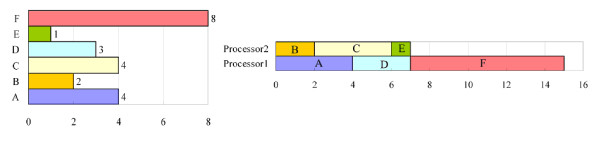
An example of the first potential problem of parallel signature discovery. The tasks can be completed in 22 time units by a single-processor computer. The overall processing time is 15 units for a two-processor computer, which exceeds the optimal processing time, 11 units.